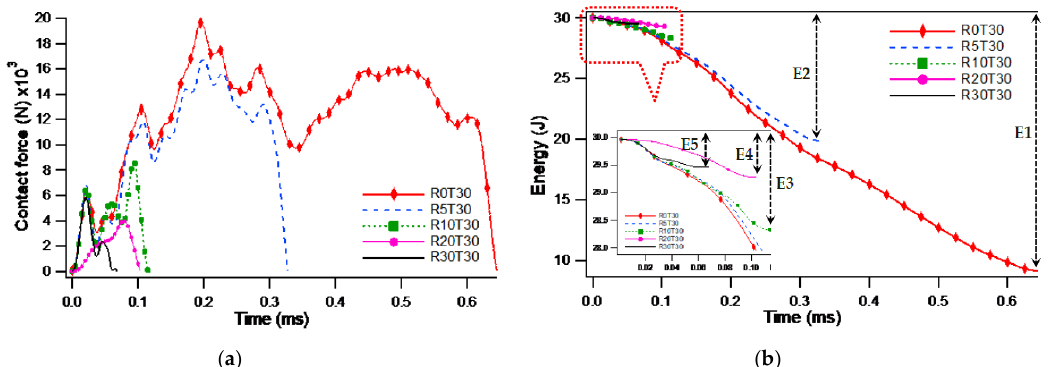
Figure 15. Comparison of 30 min sintered test specimens for: ( a ) contact force−time (F−t); ( b ) energy-time (E−t) curves of impactor; the inset is a magnification of the region indicated by the red dashed line.